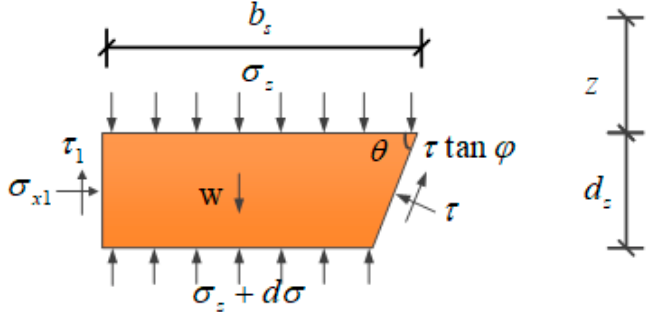
Figure 5. A slice element mechanical model of part Ⅰ .